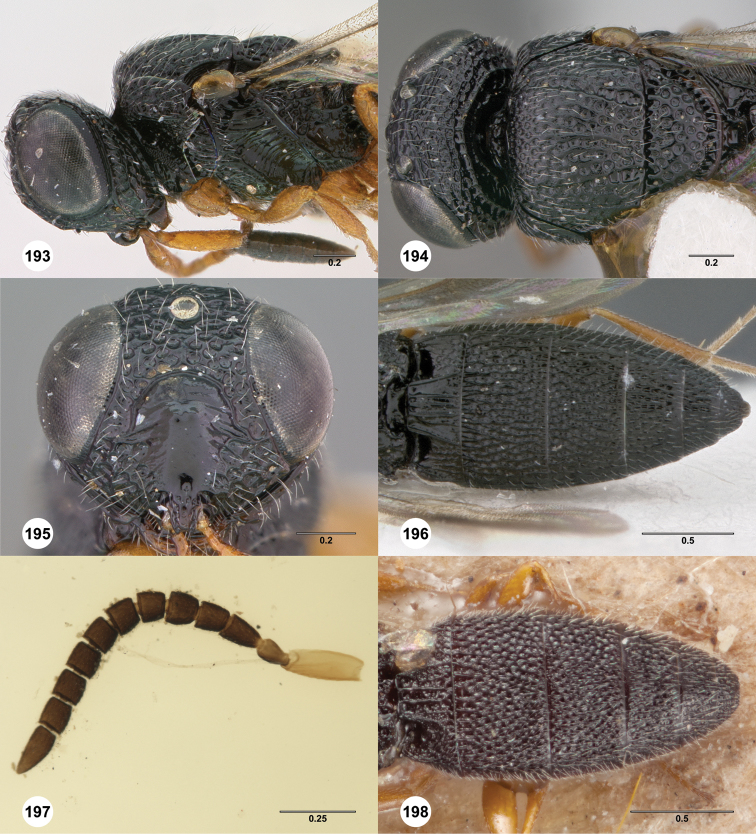
Oxyscelio montanus (Dodd), female (OSUC 441261) 193 Head and mesosoma, lateral view 194 Head and mesosoma, dorsal view 195 Head, anterior view 196 Metasoma, dorsal view. Holotype male (SAMA DB 32-001586) 197 Antenna 198 Metasoma, dorsal view. Morphbank65